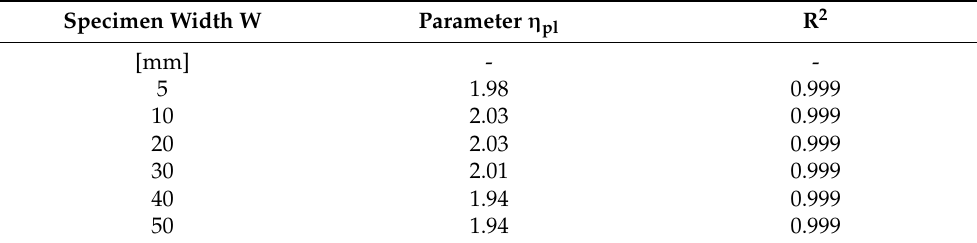
geometries (W is 5, 10, 20, 30, 40 and 50